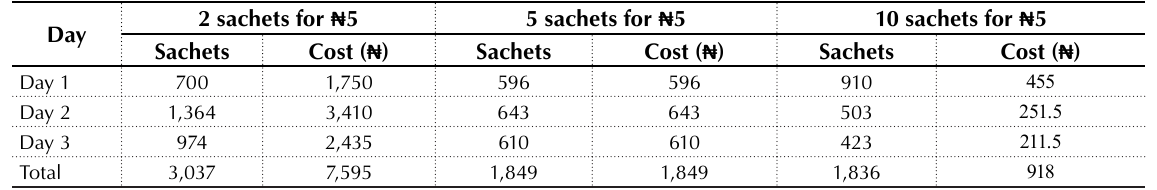
Source: Author’s